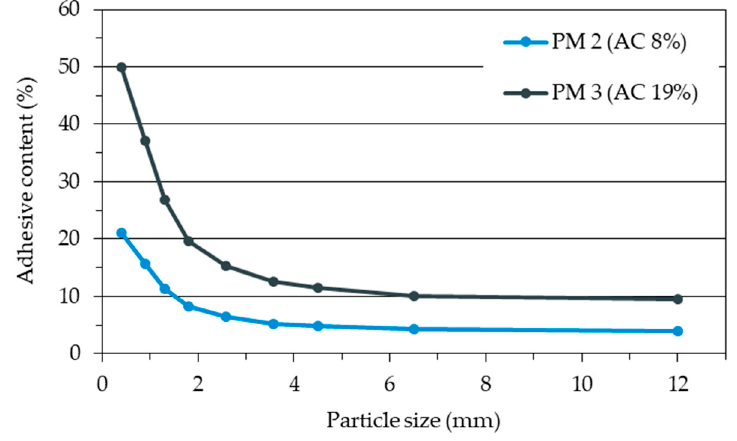
Figure 4. Theoretical adhesive content (AC) over particles according to their size for PM 2 (AC 8%) and PM 3 (AC 19%).